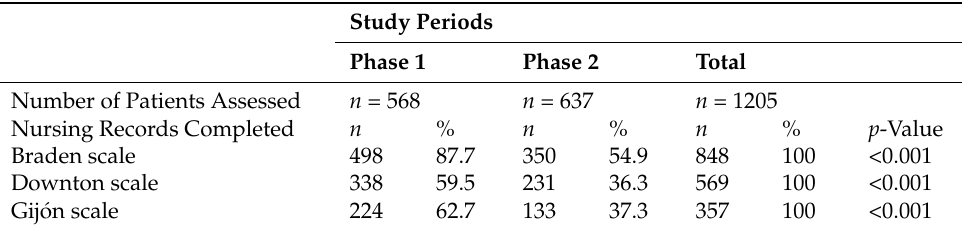
Table 2. Analyses of completion of scales for age group and sex. Phase